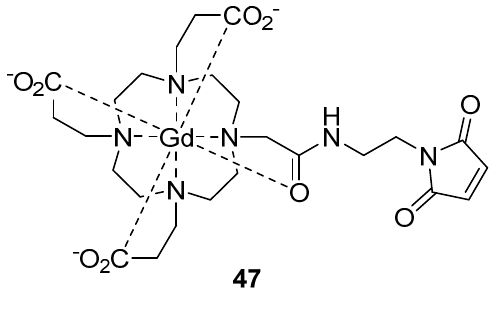
Figure 12. The Gd(III) spin label 47 ; chelated by maleimido mono amide 1,4,7,10-tetraazacyclododecane-1,4,7,10-tetraacetic acid (DOTA), which can attach to the thiol group of cysteine